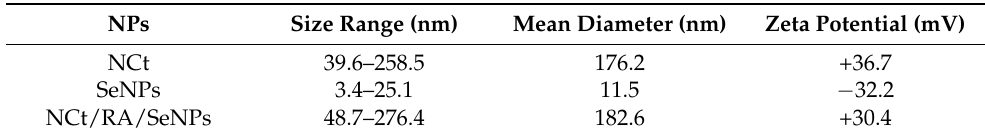
Figure 2. Scanning features of synthesized nanoparticles, including plain synthesized selenium nanoparticles ( Se ) and encapsulated rosmarinic acid/SeNPs into chitosan nanoparticles ( CG ). Table 1. The distribution of nanoparticles size and their zeta-potential for fabricated chitosan nanopar- ticles (NCt), selenium nanoparticles (SeNPs) and NCt/ rosmarinic acid/SeNPs nanocomposites